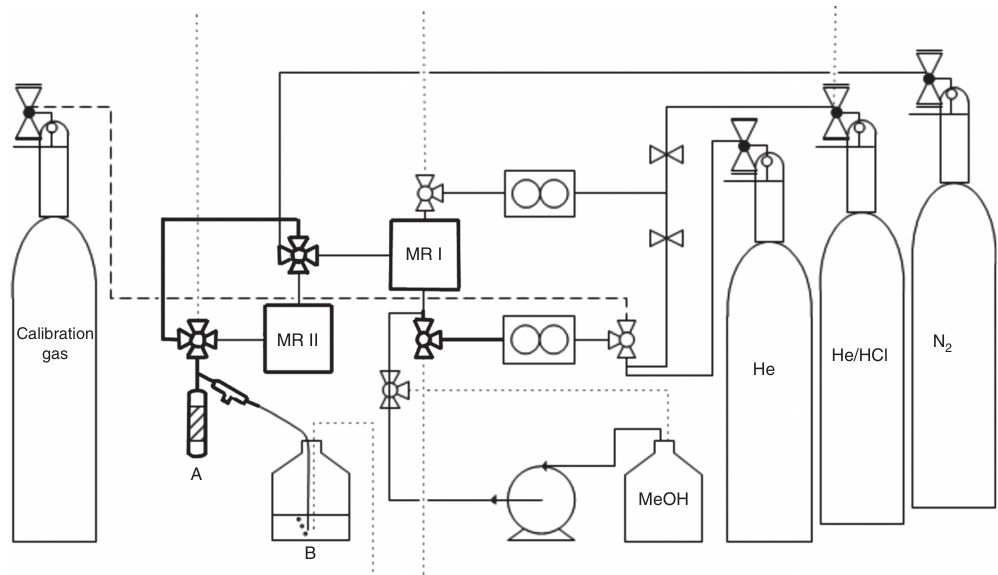
Figure 2 Schematic representation of the experimental